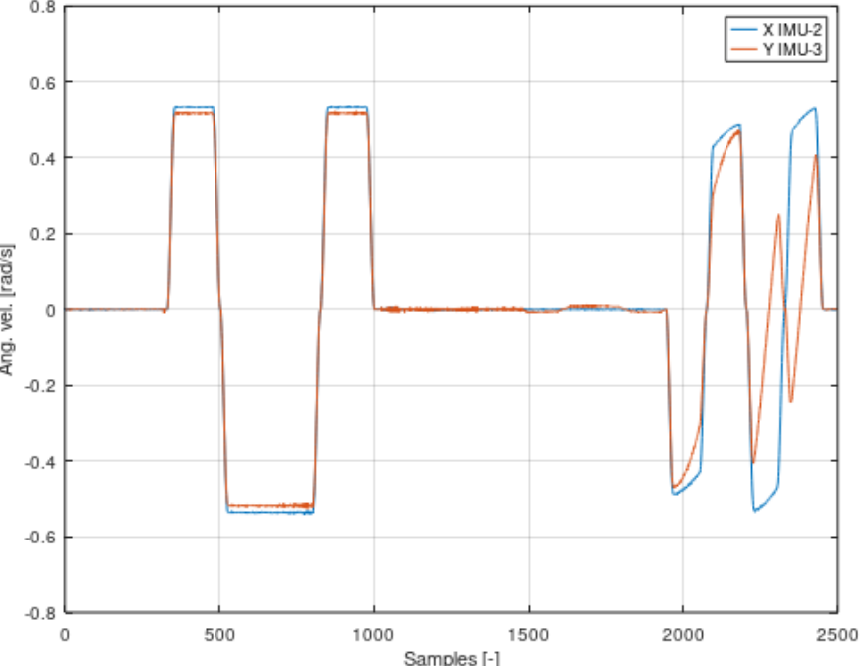
Figure 8. Summary of signals from the IMU-2 sensor of the X axis with the IMU-3 sensor of the Y axis.